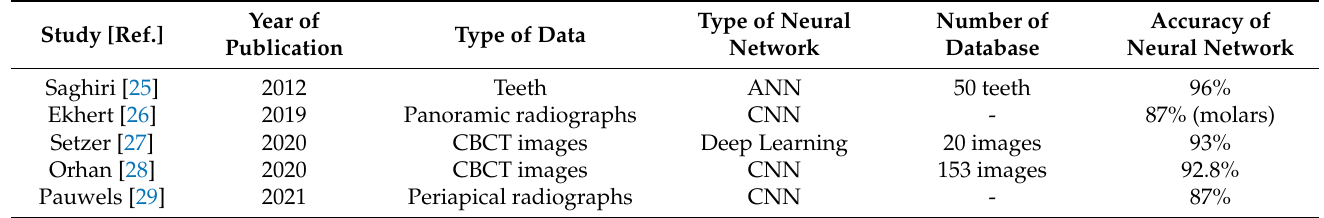
Table 2. Baseline characteristics of the studies included in the review by studying neural networks in